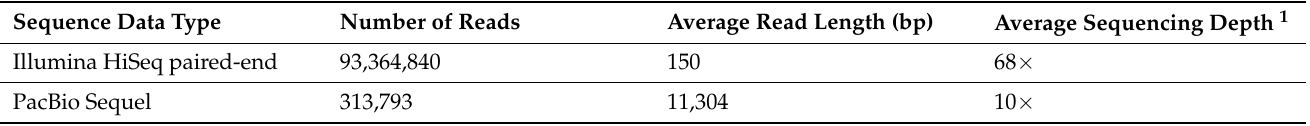
Figure 1. Distribution of single nucleotide polymorphisms (SNPs) and insertions or deletions of DNA segments (InDels) among different chromosomes. ( A ) Density distribution of SNPs among different chromosomes. ( B ) Density distribution of InDels among different chromosomes. Table 2. Statistics of the data used for hybrid assembly of the flat peach ‘124